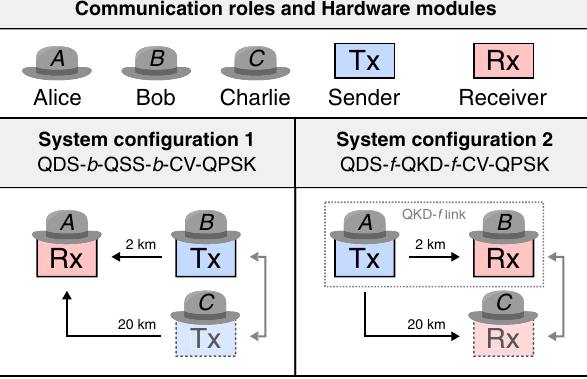
FIG. 3. The sender (Tx) and receiver (Rx) modules may be reconfigured to make Alice either the sender ( “ f configuration ” ) or receiver ( “ b configuration ” ) of quantum states. Each setup may be immediately considered versatile , since once either the f or b configuration is chosen, multiple different cryptographic tasks may be performed. Agility is implied by separation of the user and hardware layers through a stable and opaque interface (see Fig. 2). Shading and a dashed outline are used to indicate that a single device may be used to emulate two different end points as we describe in Sec.